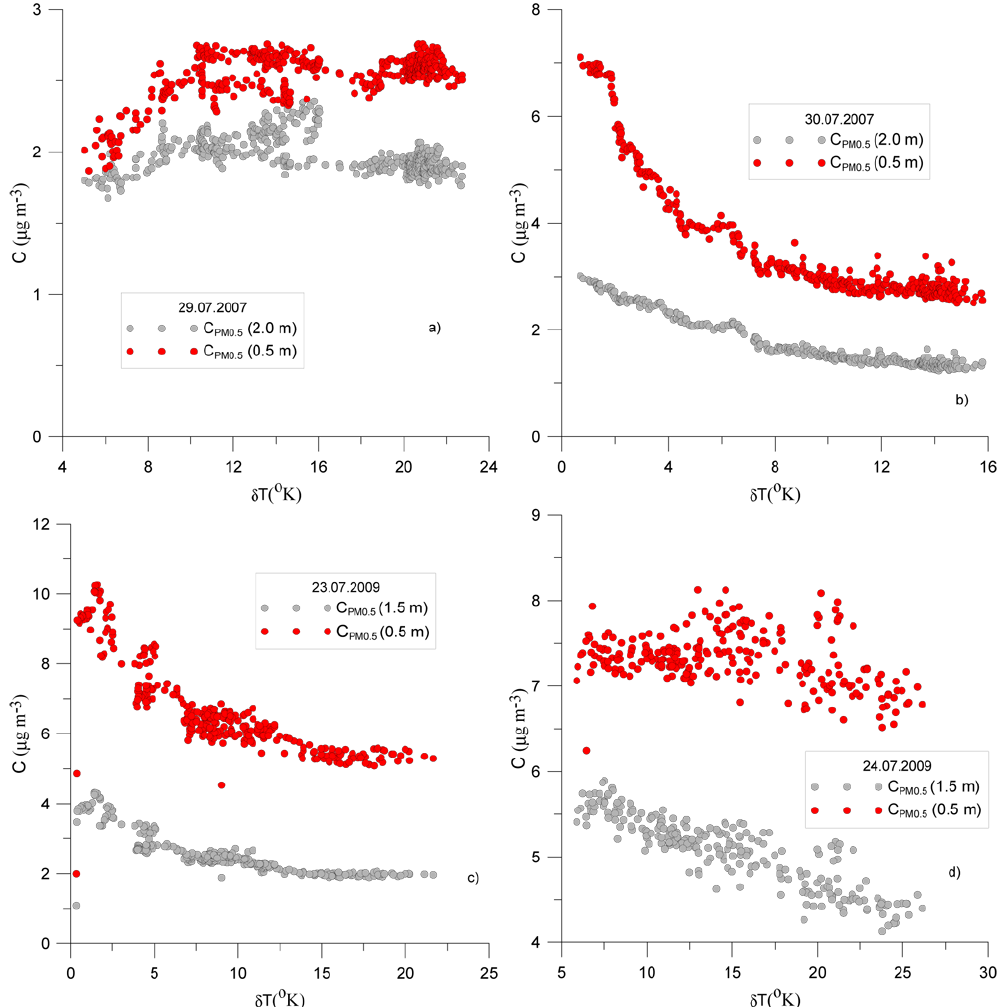
Fig. 5. Mass concentrations at heights of 0.5m C( 0 . 5 ) and 2m C( 2 . 0 ) for ( a, b), 1.5m C( 1 . 5 ) for (c, d) (µgm − 3 ) for particles 0.15–0.5µm in size and the temperature difference δT between the ground surface and 0.2m: (a) for 29 July 2007, (b) for 30 July 2007, (c) for 23